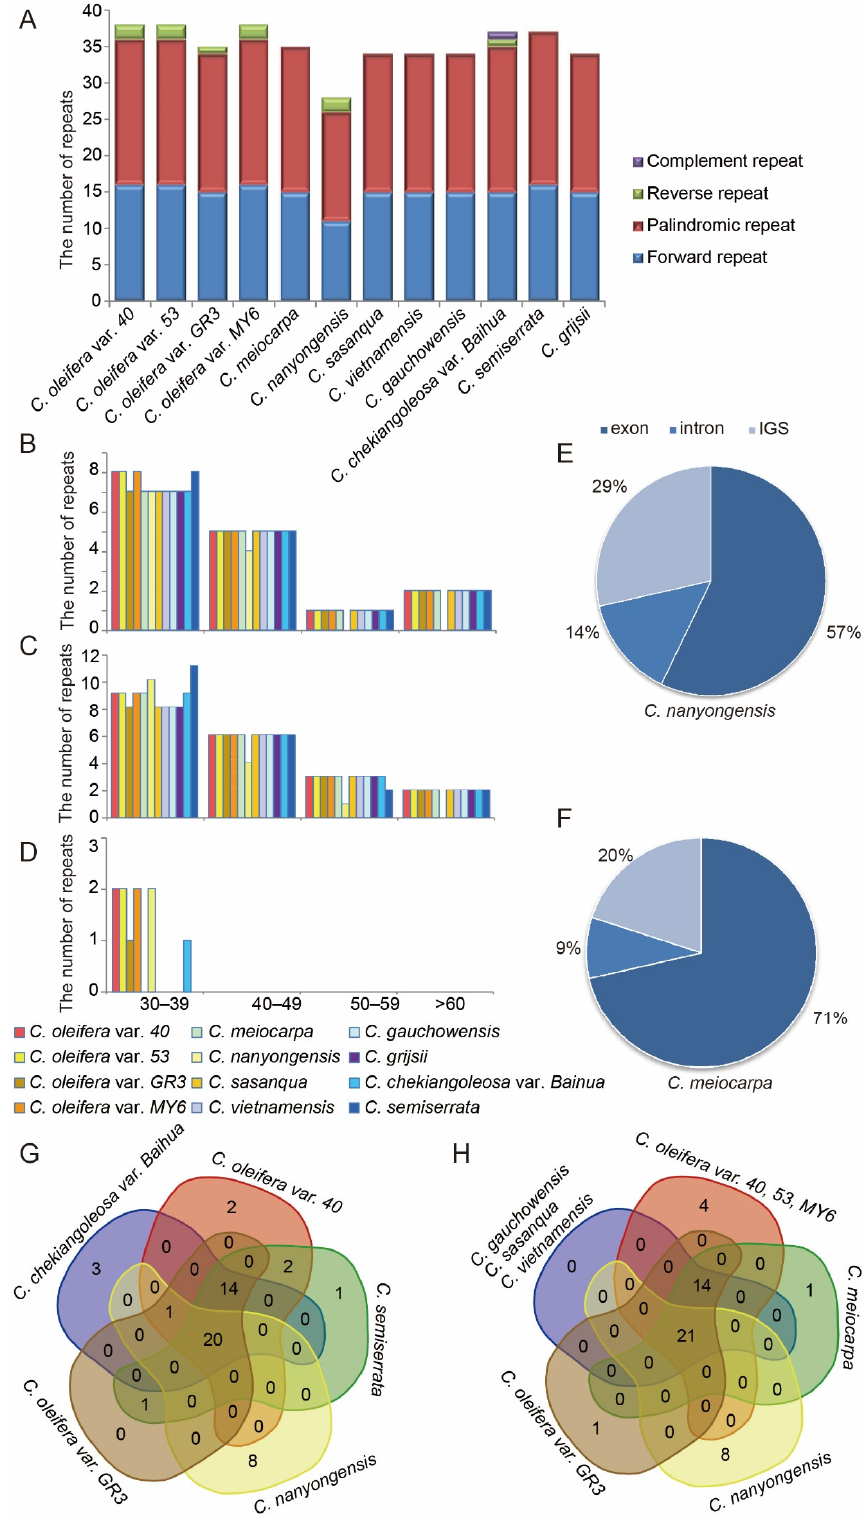
Figure 3. The type and distribution of LSRs in the 12 Camellia cp genomes. ( A ). Number of the four types of repeats; ( B – D ), Distribution of the forward, palindromic, and reverse repeats by length, respectively; ( E , F ), Location of repeats in C. nanyongensis and C. meiocarpa , which harbored the most and least repeats in exon regions in the 12 cp genomes, respectively; ( G , H ), Summary of shared LSRs among the 12 Camellia cp